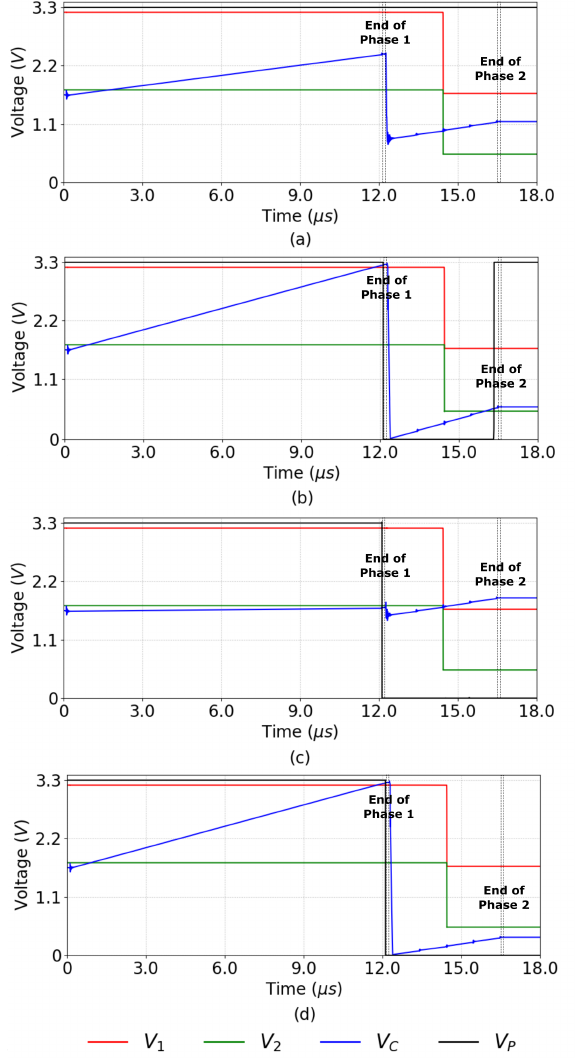
Figure 11. Post-layout simulation of defective pixel detection circuit: ( a ) a good pixel that passes the test in Line Four of Algorithm 1; ( b ) a good pixel that fails the test in Line Four of Algorithm 1; ( c ) a dead pixel. ( d ) a hot